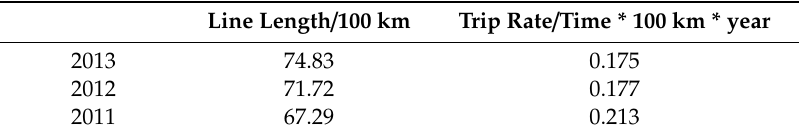
Table 6. 2011–2013 transmission line in the southwest mountainous trip rate of the State Grid Corporation of